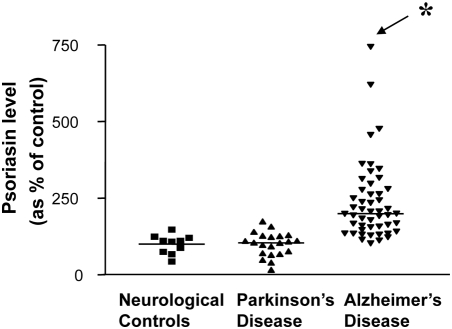
Selective elevation of S100A7 protein in the CSF of AD cases relative to neurologically normal control cases or PD cases.Monoclonal anti-human S100A7 antibody was used in a single antibody ELISA assay to quantify the content of S100A7 immunoreactivity in the CSF of non-medicated AD (n = 49), Parkinson's disease (n = 21), and neurological normal control (n = 10) cases. In this study, microtiter wells were coated with the antigen (0.5 µl CSF diluted 200-fold), dissolved in 100 µl of Buffer 42 (30 mM NaHCO3, 70 mM Na2CO3, 0.05% NaN3, pH 9.6), and incubated at 4°C overnight. Data are shown as a scatter plot. *P<0.05 vs. neurological controls or PD cases by one-way ANOVA.